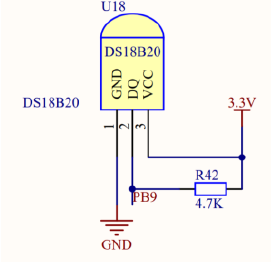
Fig. 3 . The circuit diagram of the temperature sensor DS18B20.